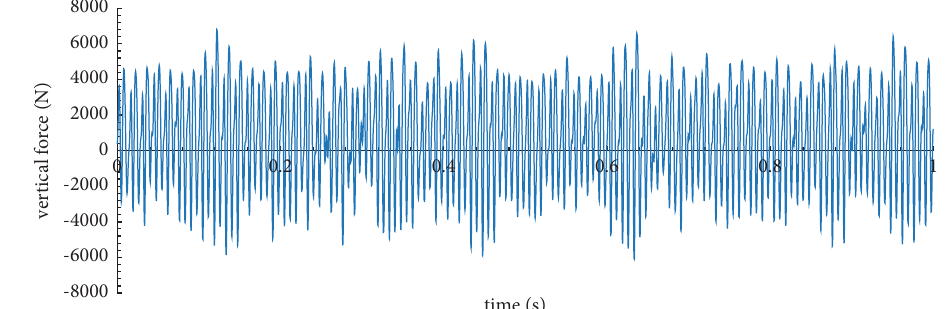
Figure 2: Vehicle dynamics model with motor car.